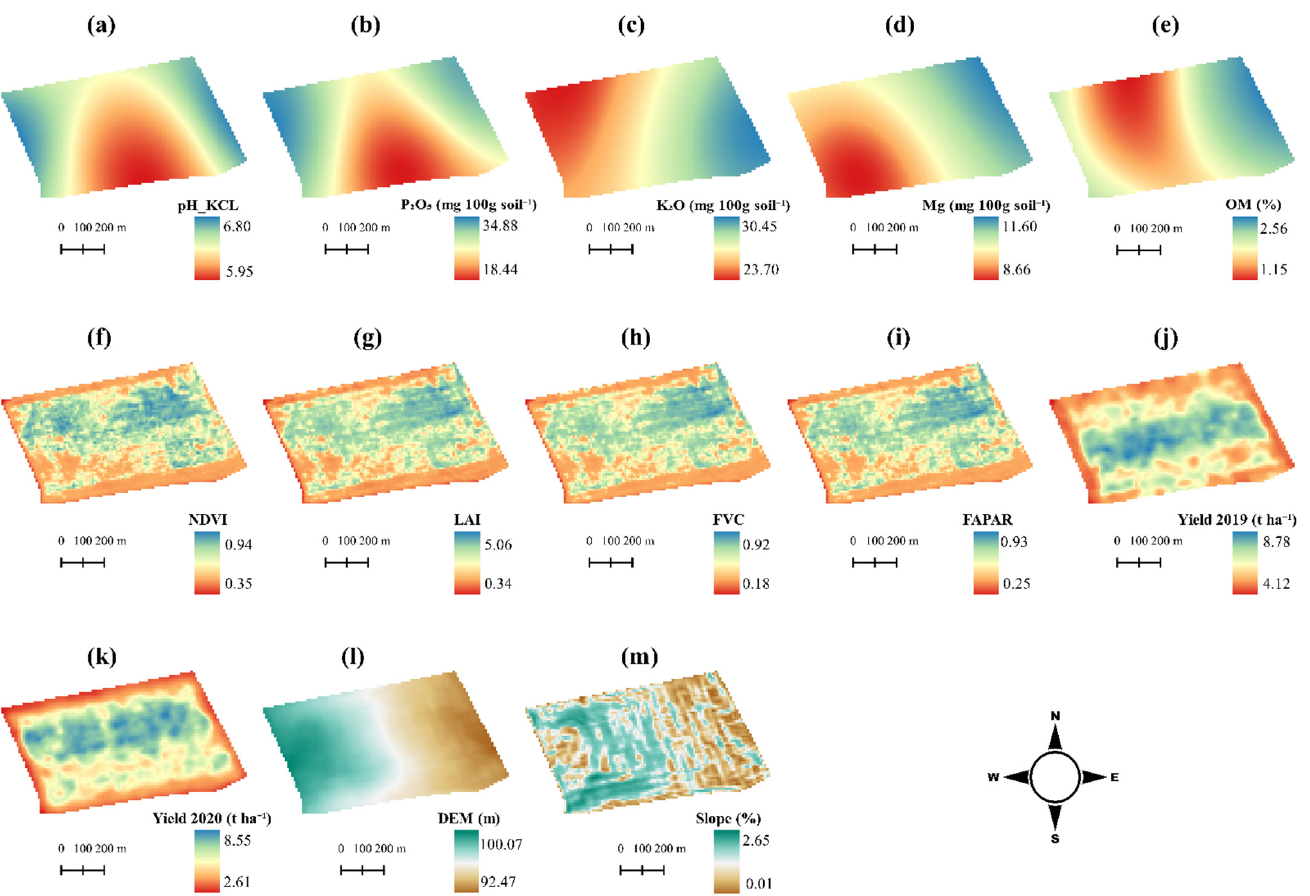
Figure 7. Spatial distribution maps of soil attributes including pH KCl ( a ), P 2 O 5 ( b ), K 2 O ( c ), Mg ( d ) and OM ( e ), the spatial distribution maps of RS data including NDVI ( f ), LAI ( g ), FCV ( h ) and FAPAR ( i ), the spatial distribution maps of yield for 2019 ( j ) and 2020 ( k ) and the spatial distribution maps of geomorphology data including DEM ( l ) and Slope ( m ).